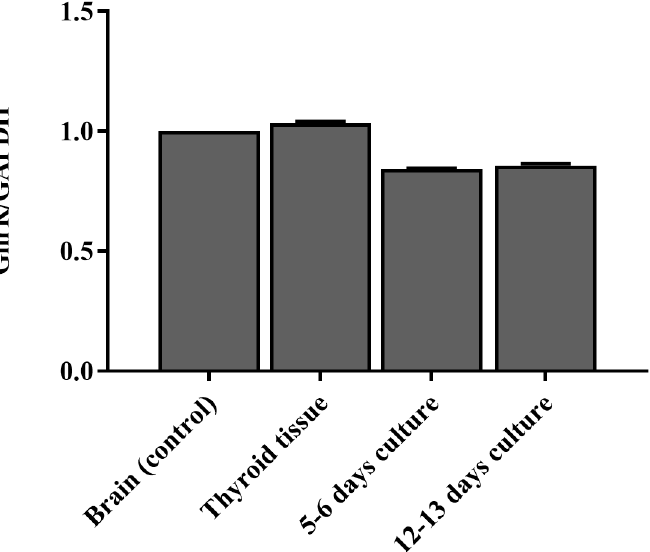
Fig 1. Ghrelin receptor(GhrR) mRNA expression level. GhrR mRNA expressionlevel in relation to the reference gene glyceraldehyde-3-phosphate dehydrogenase (GAPDH) mRNA expressionlevel in human brain, thyroid tissue and cell cultures measured by real-time quantitative polymerase chain reaction(RT- qPCR). n = 2.